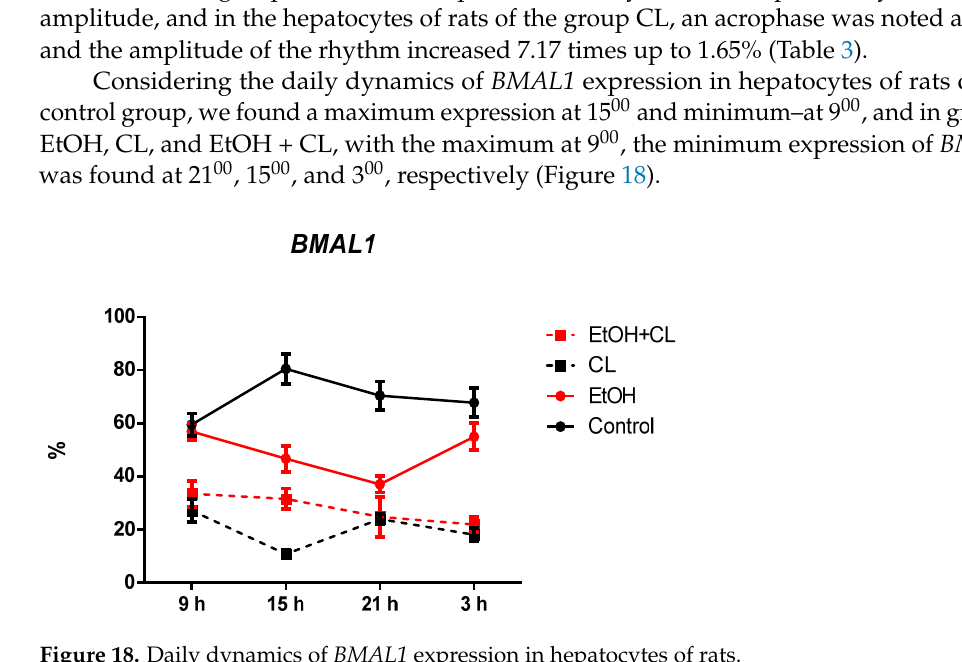
Figure 19. Daily dynamics of PER2 expression in hepatocytes of rats. Significant CRs were noted in the control group—acrophase at 3 16 and amplitude of 9.22%—and in EtOH and CL groups, with similar parameters—acrophases at 13 39 and 13 16 and an amplitude of 14.41% and 15.03% (1.56 and 1.63 times higher than in control group), respectively (Table 3). Table 3. Results of the cosinor analysis of the daily dynamics of the expression of the studied genes.